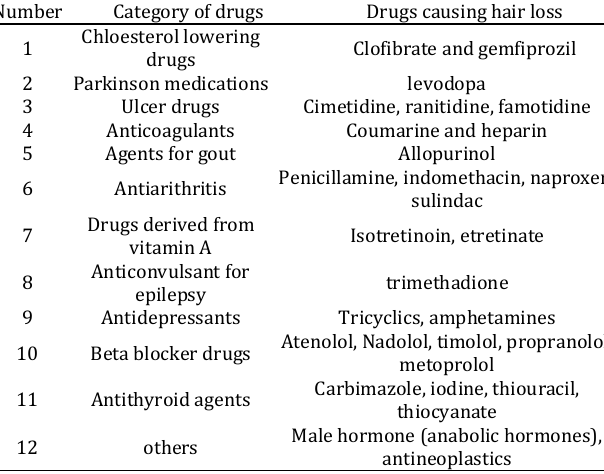
Table 1. Drugs causing hair loss (20) .